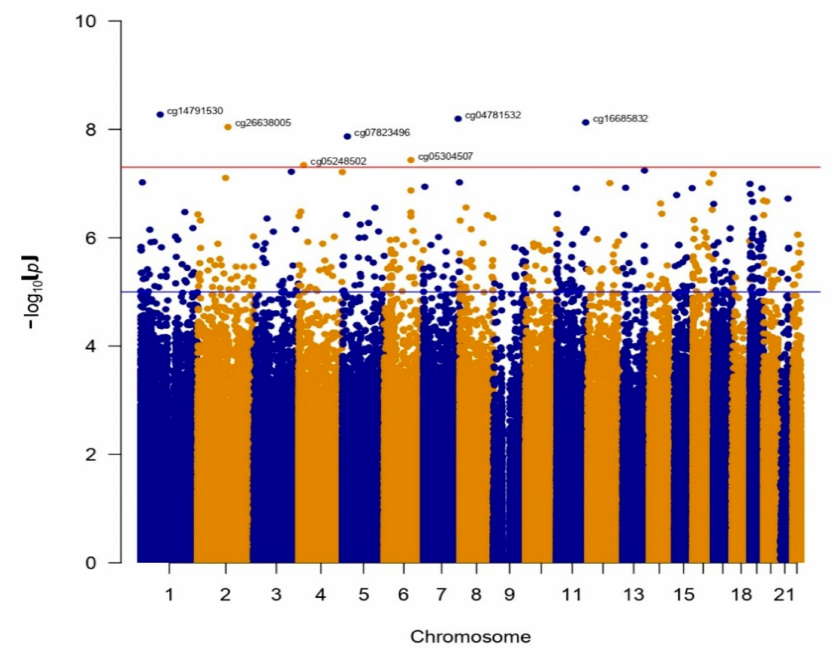
Figure 1. Manhattan plot of the comparison of BED and